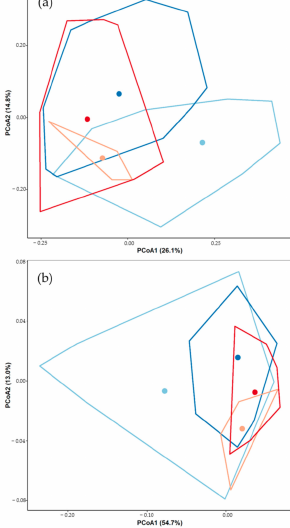
Figure 3. Principal coordinates analysis (PCoA) indicating the average (centroid) and spread (convex hull) of macroinvertebrate community compositions displayed by each BACI level. Before control = orange; after control = red; before restoration = light blue; and after restoration = dark blue. ( a ) Taxonomic compositions and ( b ) functional